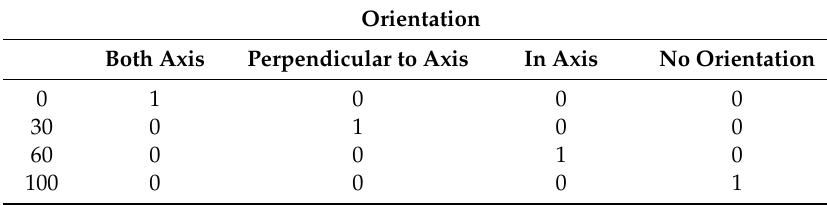
Table 9. Rule base for orientation.